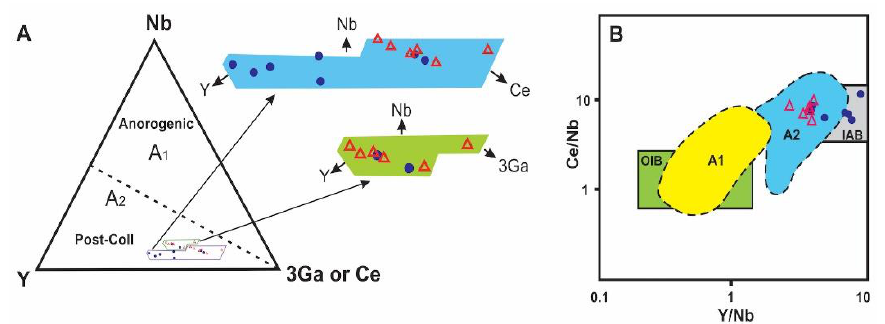
Figure 7. Plots of Wadhrai analyses on granitoid discrimination diagrams. ( A ) Nb – Y – 3Ga and Nb – Y – Ce ternary diagrams [28] used for distinguishing A 1 and A 2 sub-type granitoids. ( B ) Ce/Nb vs. Y/Nb relations, showing fields of oceanic island basalt (OIB), A 1 and A 2 -type granites and